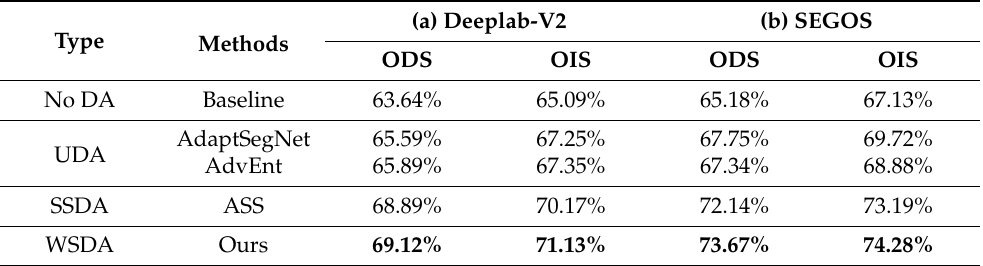
Table 2. Accuracy comparison among different domain adaptation methods based on the (a) Deeplab- V2 [45] model and (b) SEGOS model.